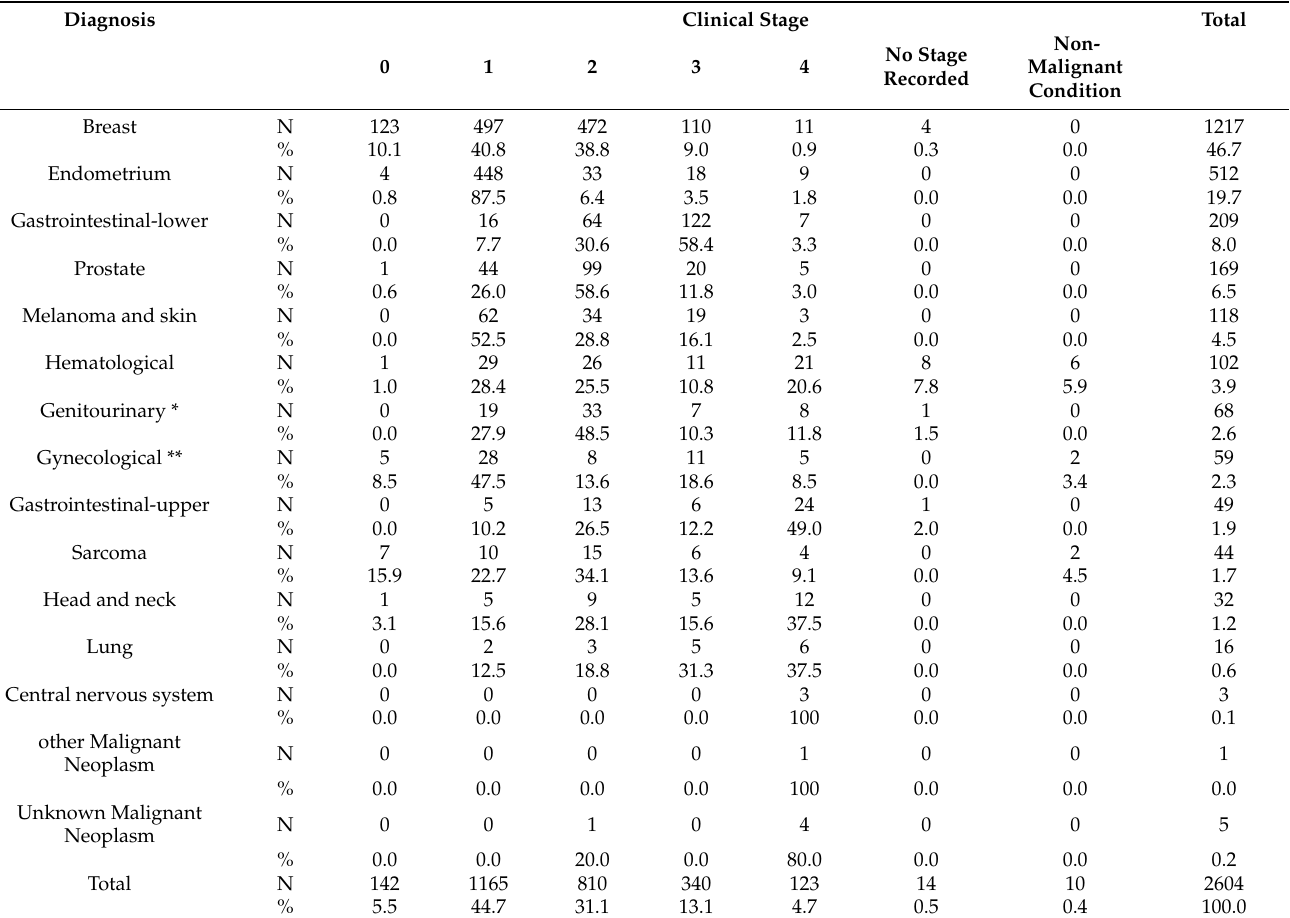
Table 1. Clinical stage at the time of transition, n =